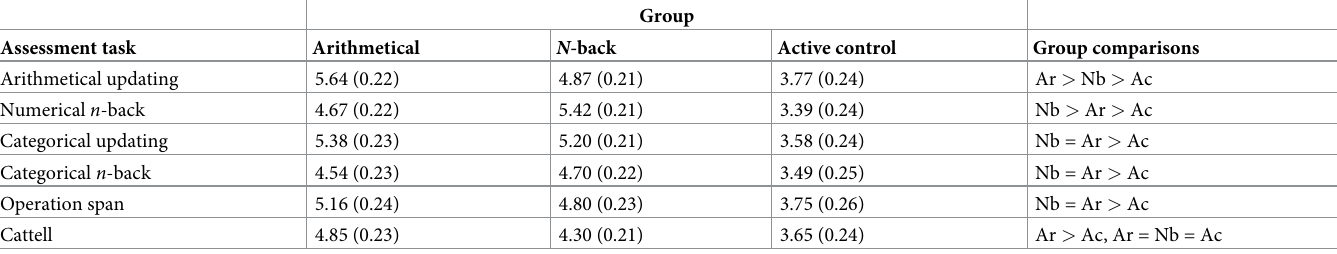
Table 4. Means and standard errors for self-perceived improvement in each task by